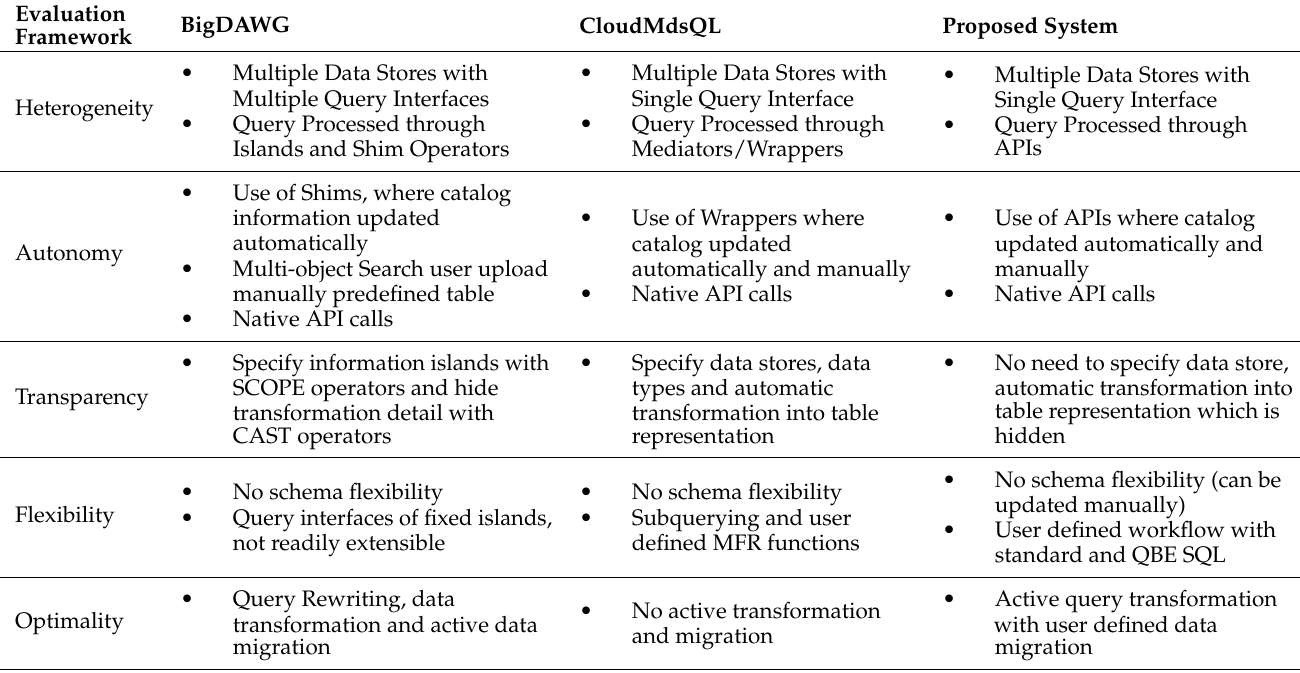
Table 6. Evaluation based on features of Polystore